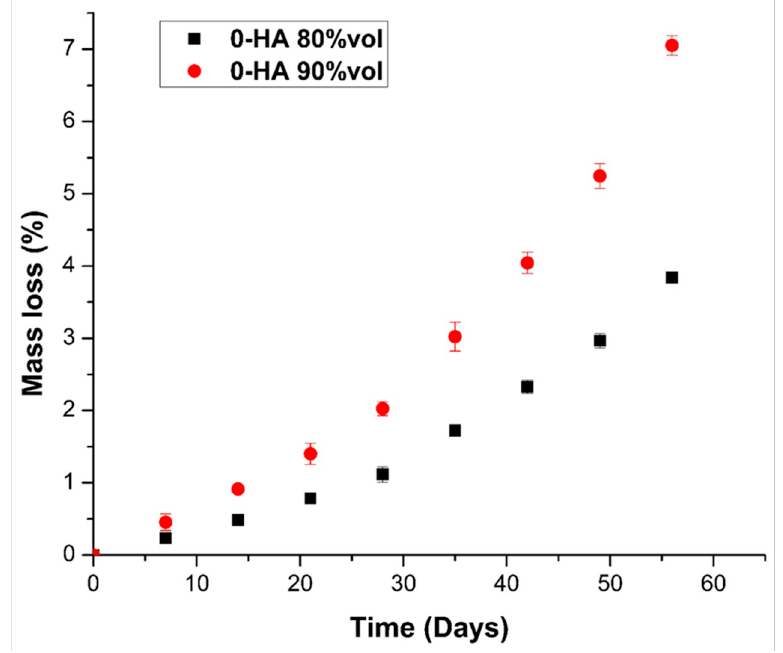
Figure 8. Degradation of poly(TT / DPEHA)HIPEs with 80 and 90% by volume of aqueous for 55 days.